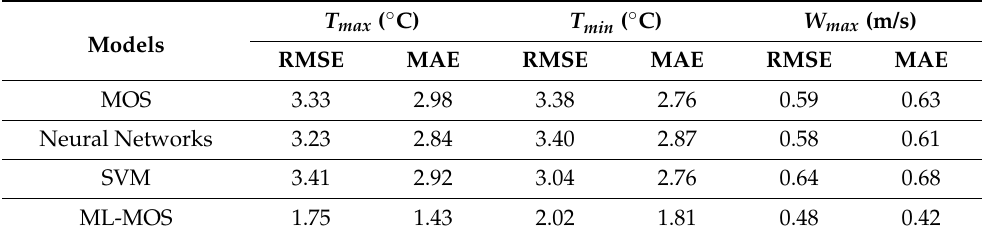
Table 3. RMSE and MAE values corresponding to the neural networks, SVM, and ML-MOS model. Models